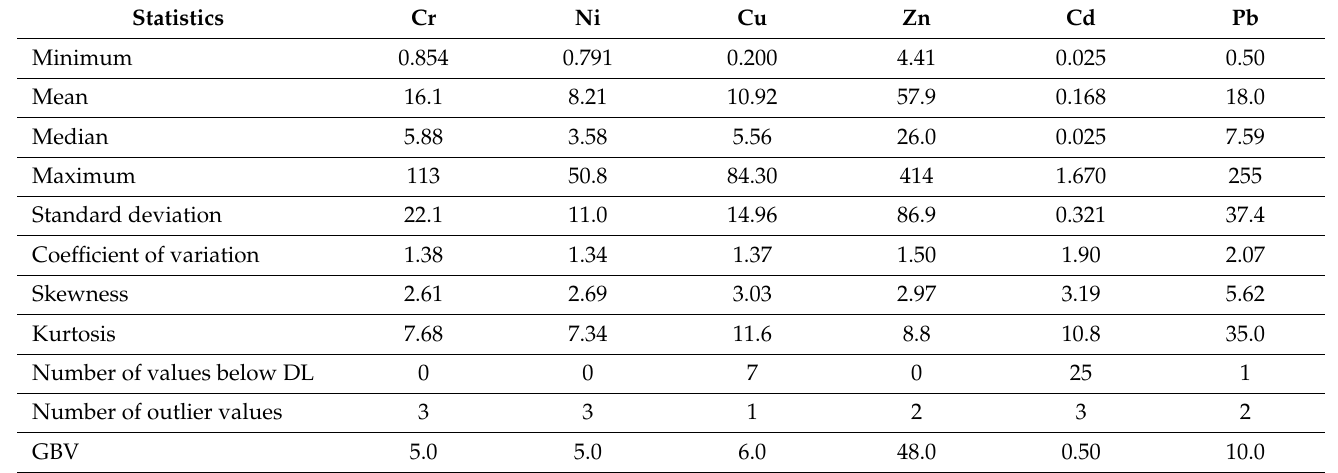
Table 2. Summary statistics of heavy metal concentrations (mg · kg − 1 ) in river sediments.